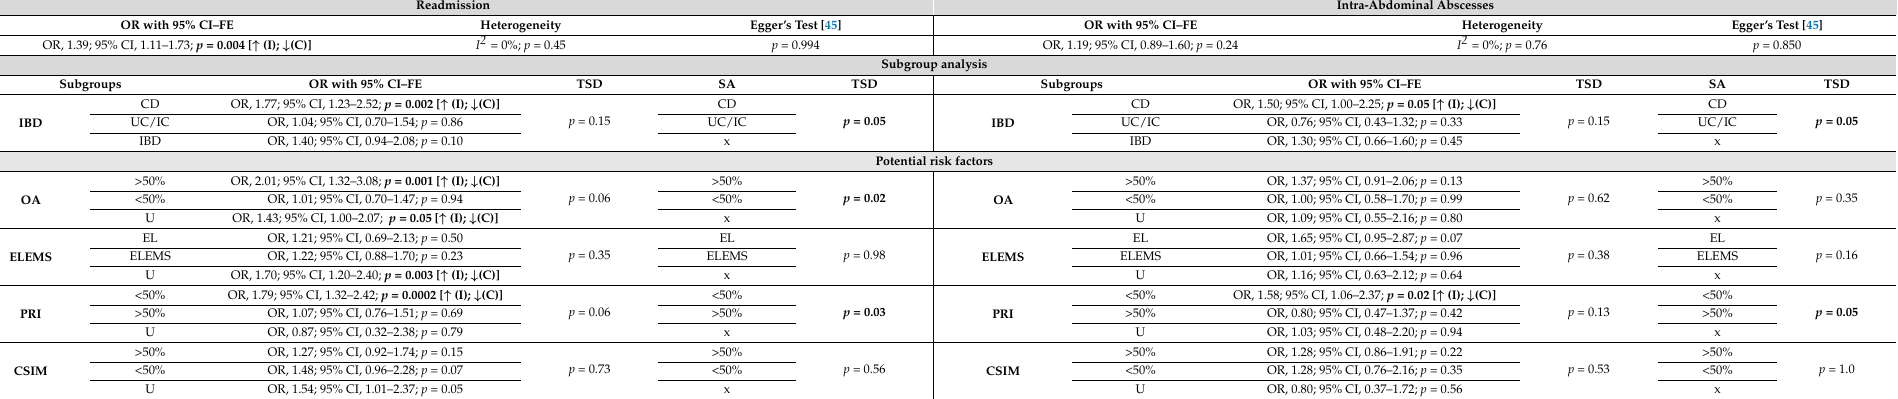
Table 3. The fixed-effect model meta-analysis for 30-day postoperative readmission and intra-abdominal abscesses in the anti-TNF- α (intervention) and control group. Analysis for publication bias and subgroup